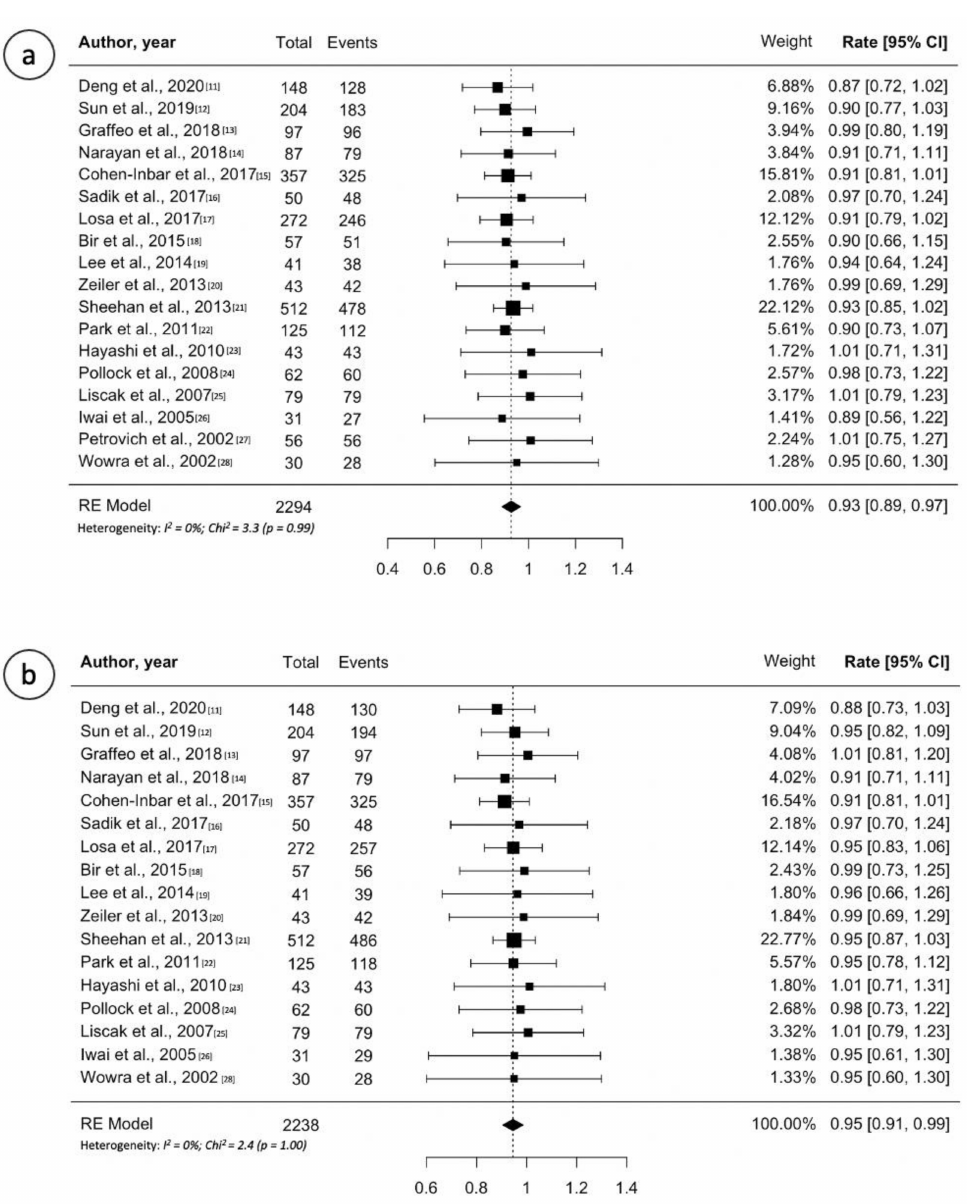
Figure 2. ( a ) Forest plot of overall tumor control following Gamma Knife treatment for non- functioning pituitary adenomas; ( b ) Forest plot of 5-year progression free survival after Gamma Knife treatment for non-functioning pituitary adenomas. Random effects models pooled estimates are presented and heterogeneity analysis are